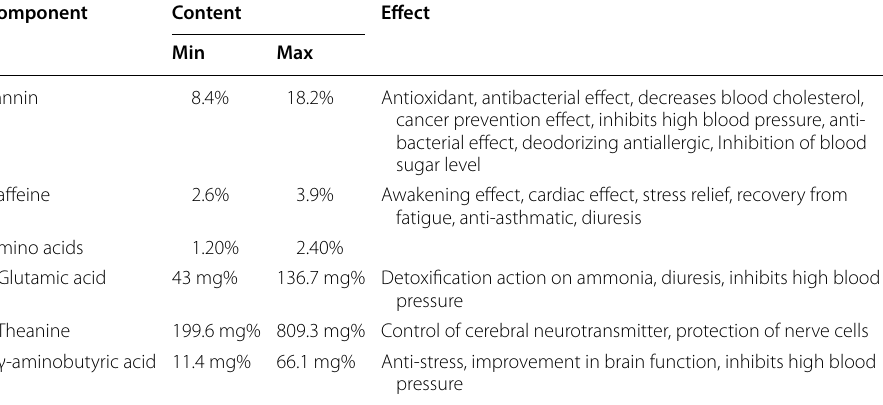
Table 1 Tea components and their major effects on human health (Sakamoto et al. 2012; Nihon